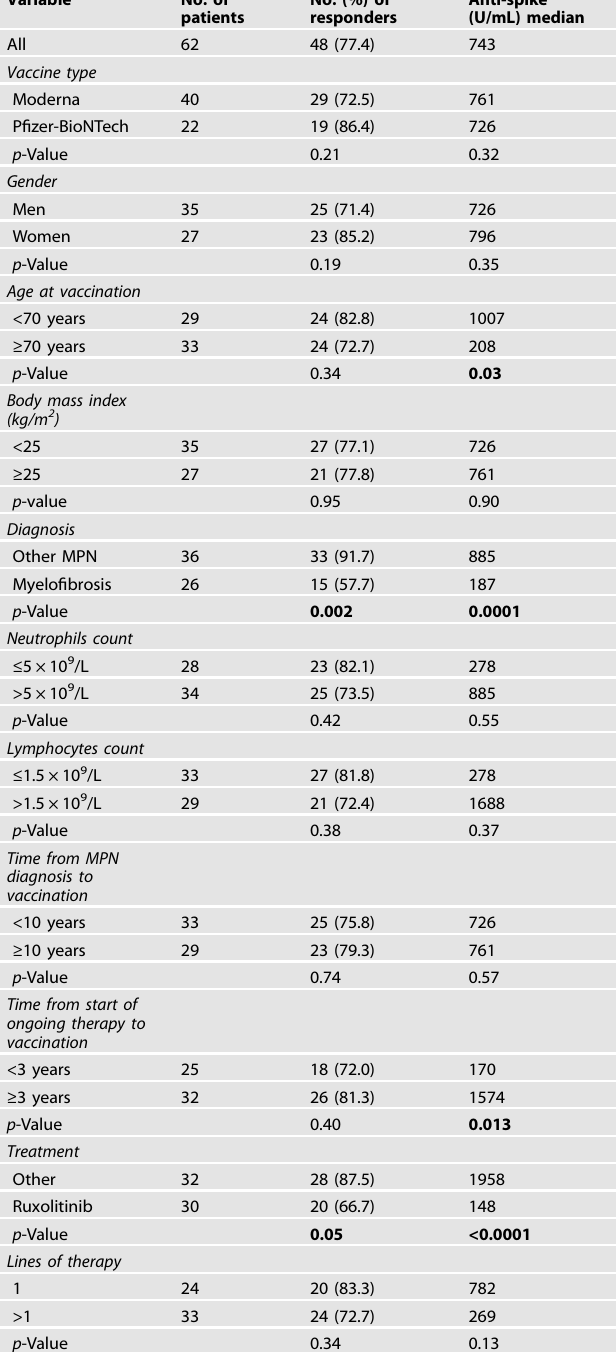
* From chi-squared (for percentage of responders) or Mann – Whitney (for anti-Spike titer) test. Bold values indicates statistically signi fi cant p